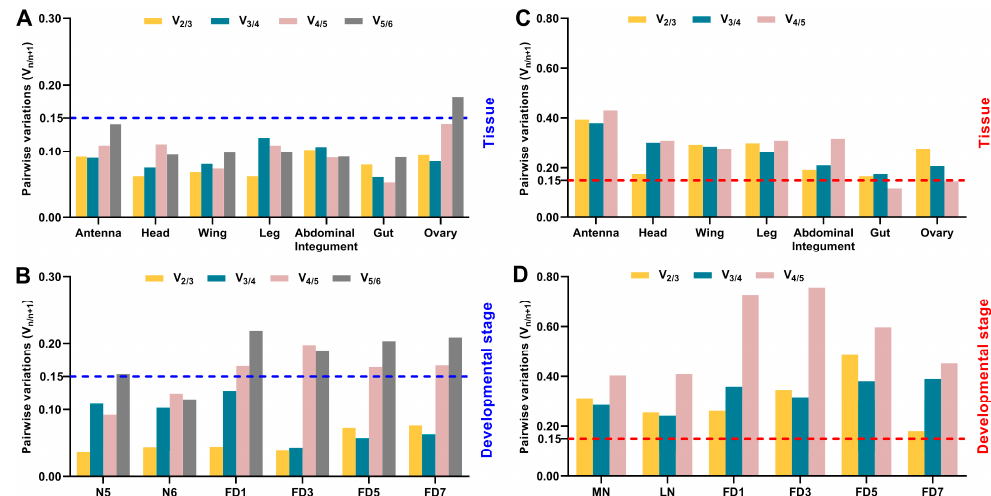
Figure 5. Evaluation of the optimal number of reference genes required for spatiotemporal expression profiling. The pairwise variation V n/n+1 , where n is the number of reference genes, was calculated by geNorm algorithm using the C t values: ( A ) from different developmental stages in a specific tissue type of B. germanica ; ( B ) from different tissues at a given developmental stage in B. gremanica ; ( C ) from different developmental stages in a specific tissue type of P. americana ; ( D ) from different tissues at a given developmental stage in P. americana .